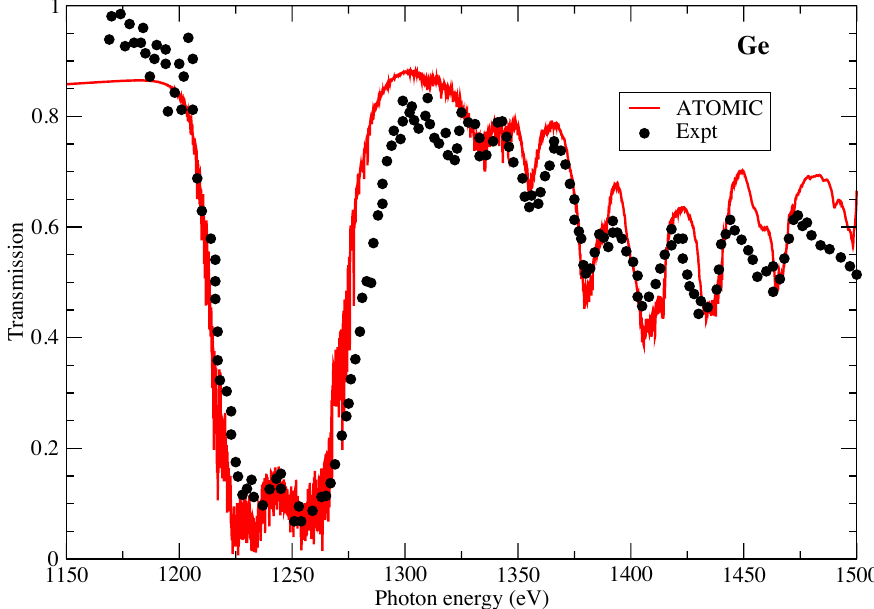
Figure 3. The transmission of Ge as measured by [31]. The experimental data are compared with ATOMIC calculations at a temperature of 38 eV and a mass density of 0.012 g/cm 3